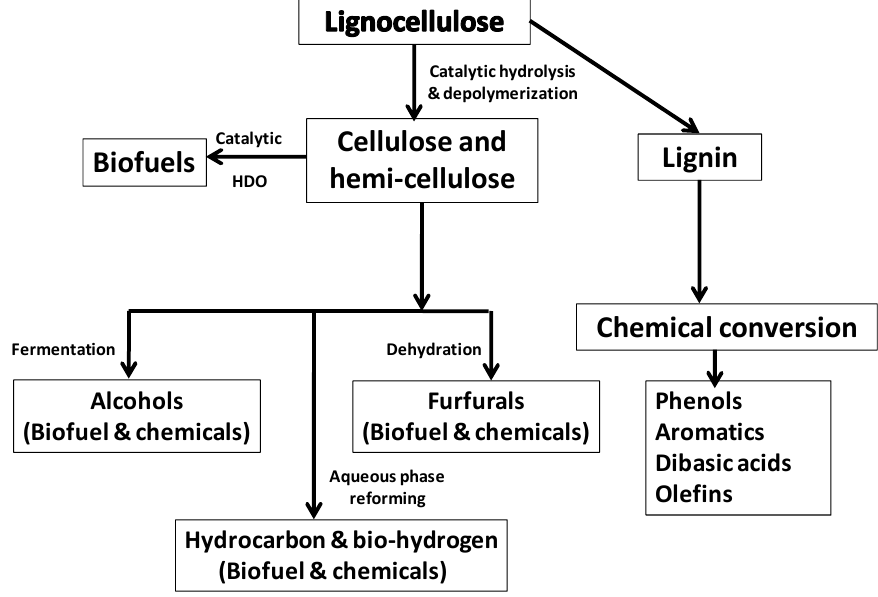
Figure 1. The possible scheme for a chemo-catalytic biorefinery.